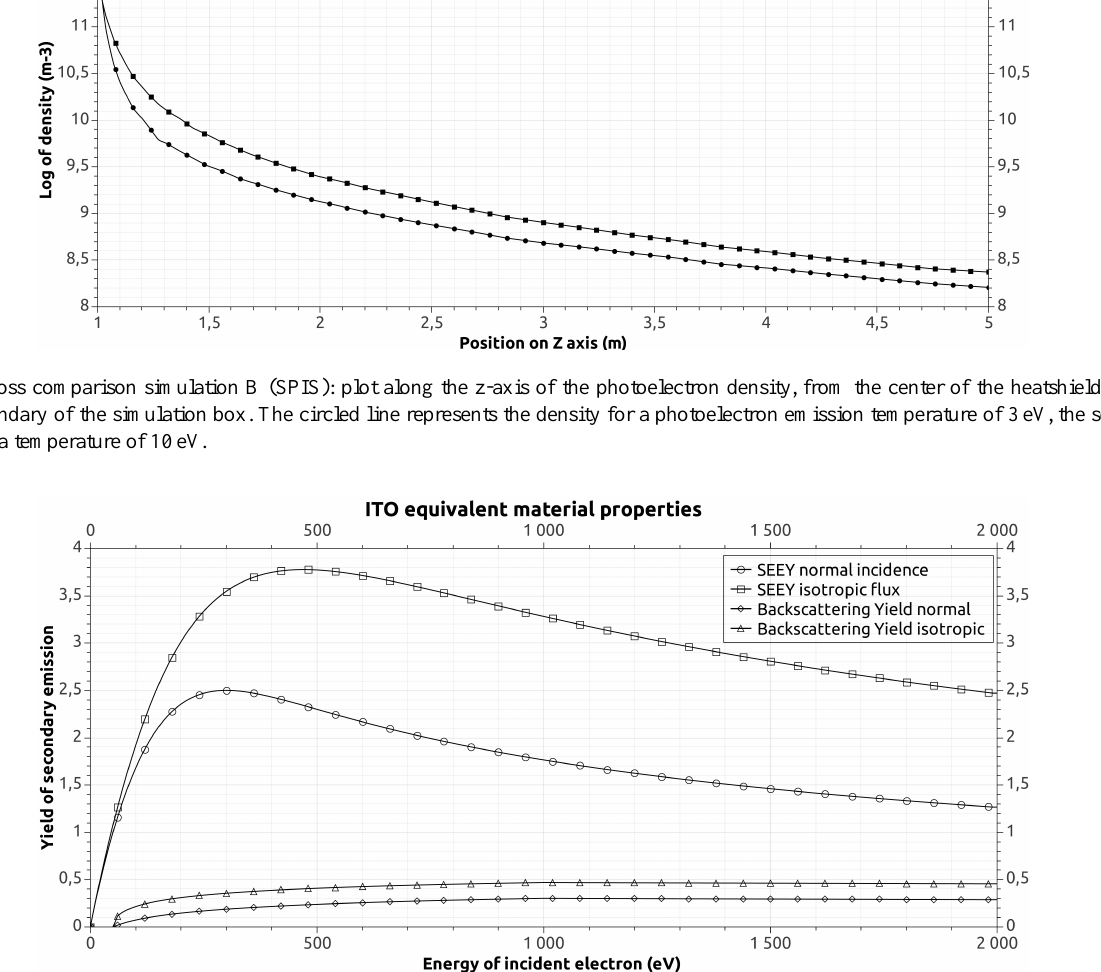
Fig. 10. Secondary electron emission yield (SEEY) and the backscattering yield of ITO material (used in parametric study) vs. incident electron energy (with a normal or isotropic incoming